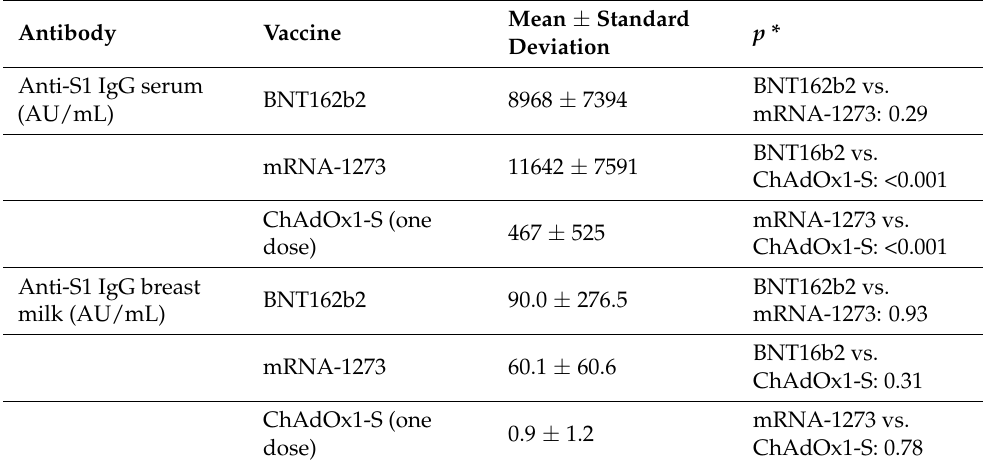
Table 6. Levels of anti-S1 antibodies (IgG) in serum and breast milk according to the type of